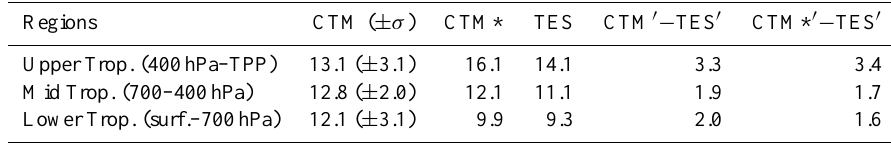
Table 1. Means and root mean squares (RMS) of the exact matching TES and CTM partial ozone columns (unit: DU) of the TES